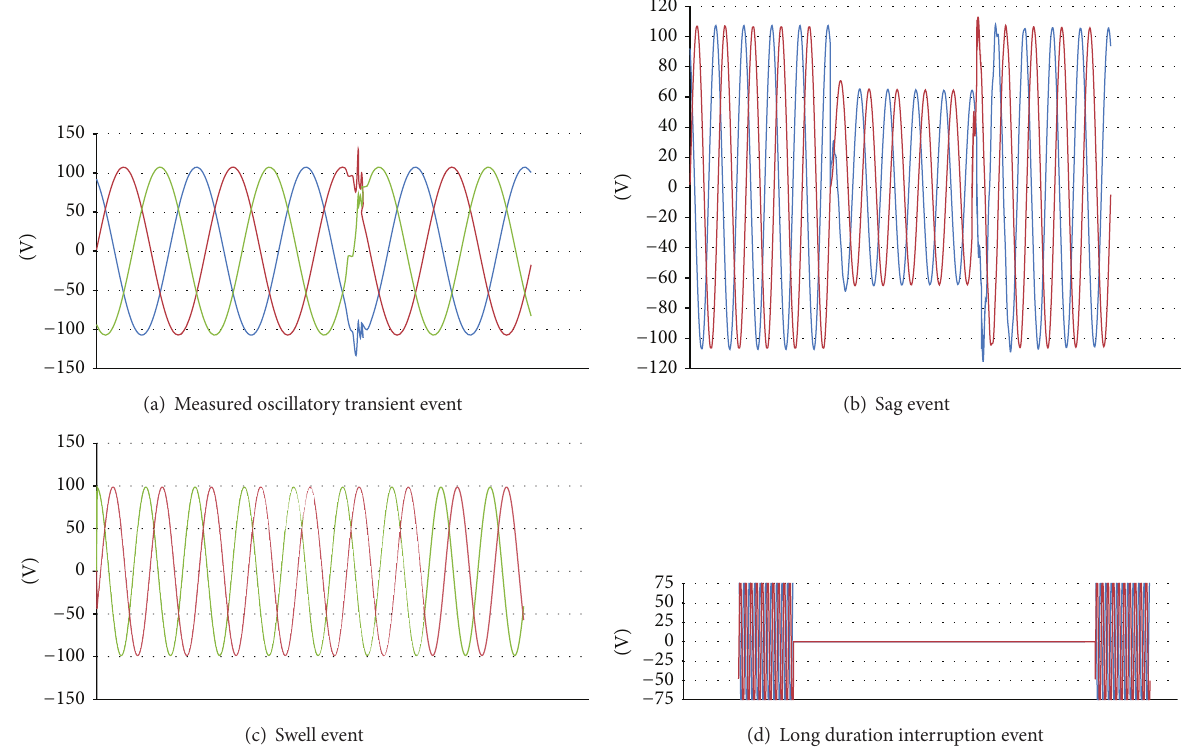
Figure 2: Waveform of various recorded